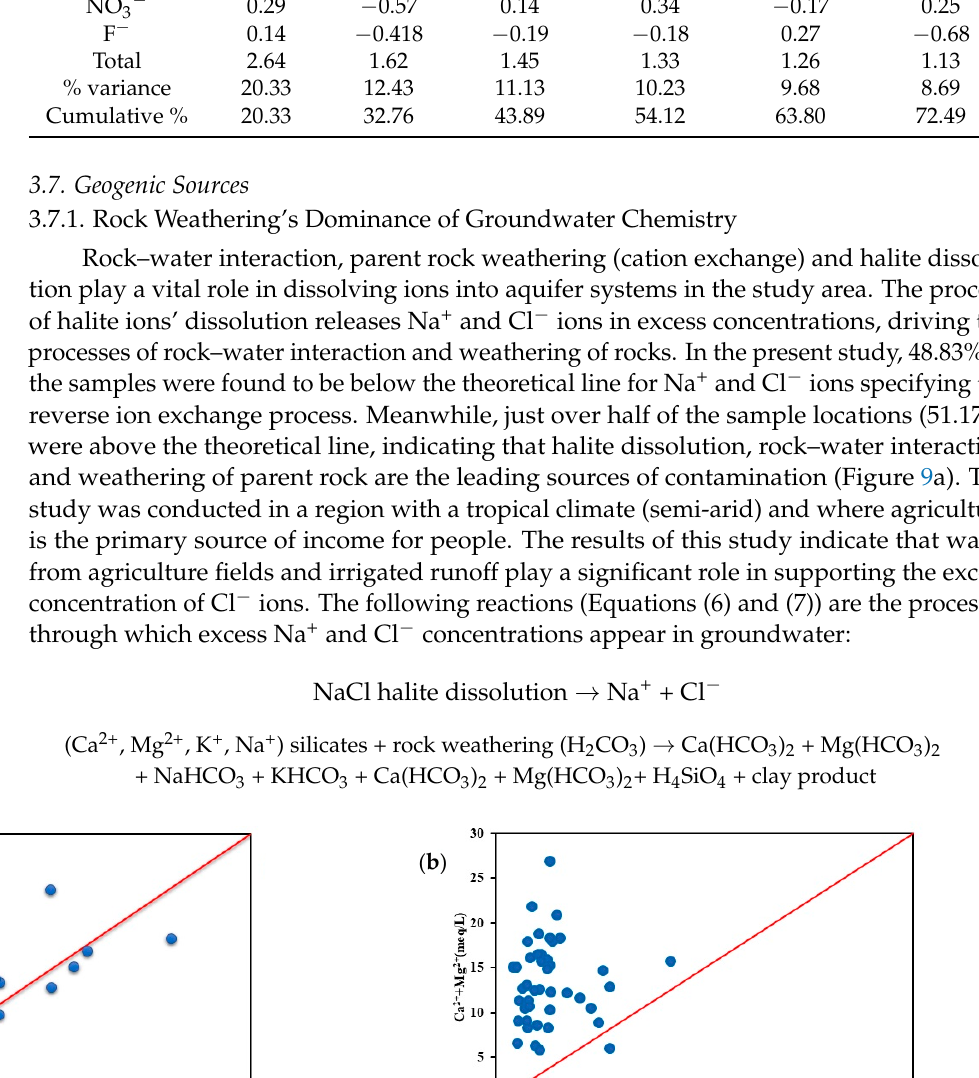
and HCO 3 − resulted from carbonate (calcite) rocks, as proven by plotting the bivariate di- agram of HCO 3 − vs. Cl − +SO 4 2 − (Figure 10a). About 88.37% of the sampling points were